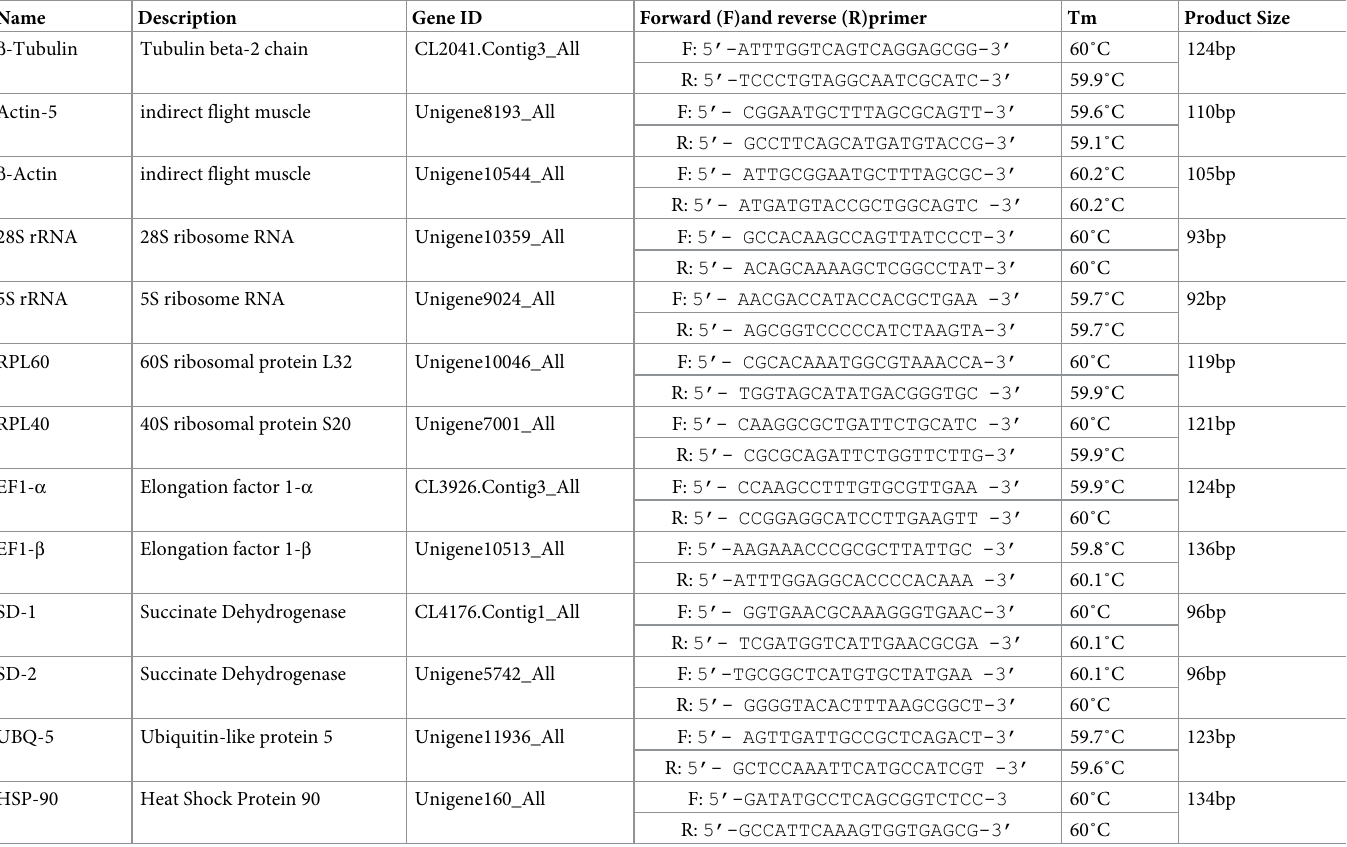
Table 1. Primer sequences used in real-time PCR of Bactrocera cucurbitae reference